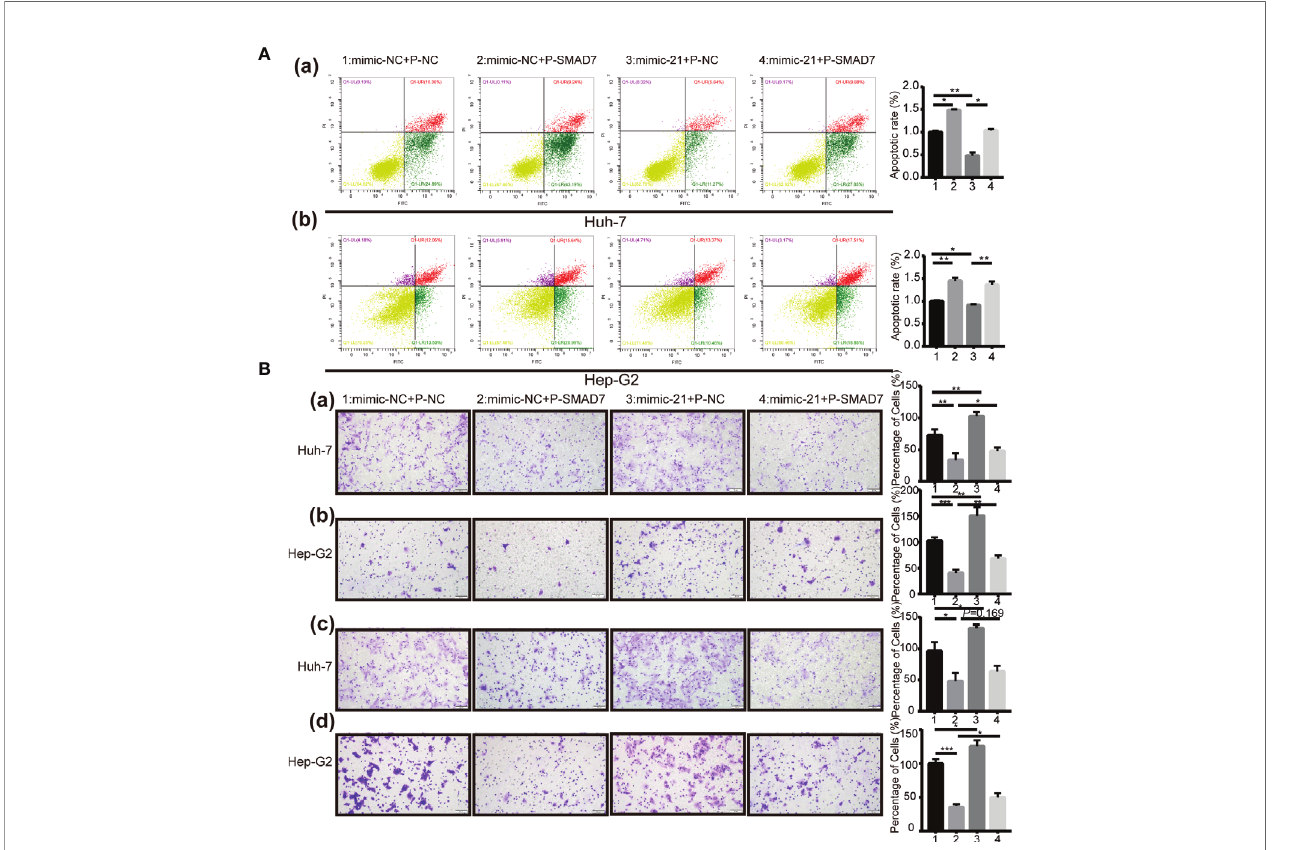
FIGURE 4 | Effects of miR-21-3p on malignant HCC phenotypes could be partly reversed via SMAD7 overexpression. (A) Flow cytometry was performed to analyze the apoptotic index of Huh-7 (a) and Hep-G2 (b) cells after transfection. Cells were co-stained with Annexin FITC/PI; Annexin FITC+/PI- cells that stained green were considered as being in early apoptosis. Normal, late-stage apoptotic and necrotic cells are shown in yellow, red and purple, respectively. Three independent experiments were performed. Data are shown as mean ± SD. (B) Transwell assay was performed to detect the migration (a, b) and invasion (c, d) in Huh-7 and Hep-G2 cells separately after transfection. *P < 0.05, **P < 0.01; ***P <